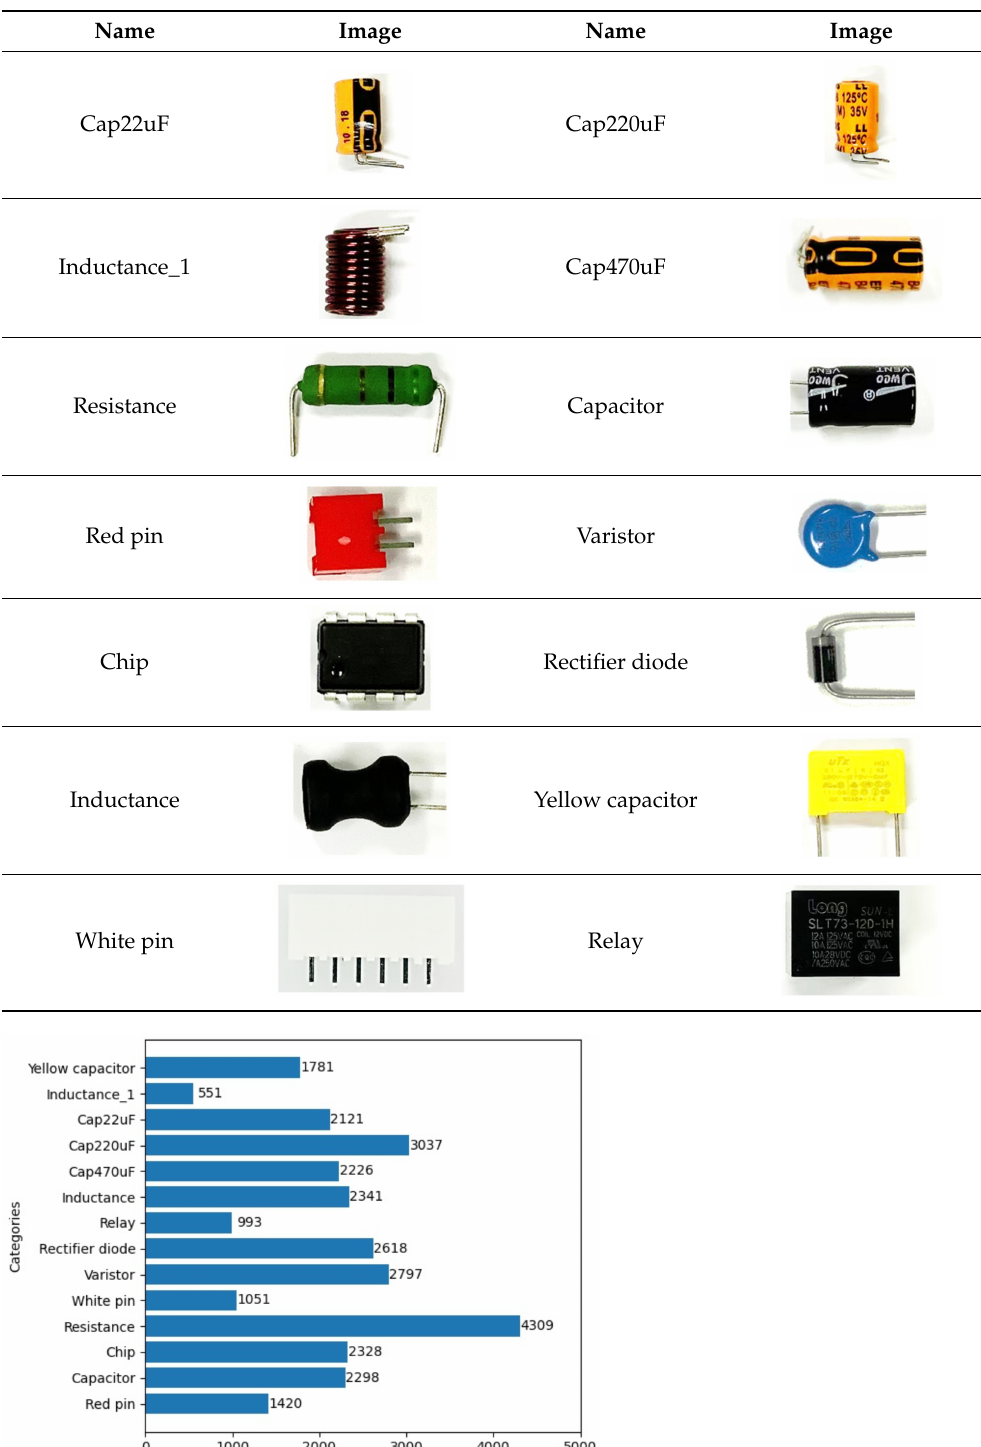
Table 1. Multi-scene electronic components dataset categories and corresponding images.